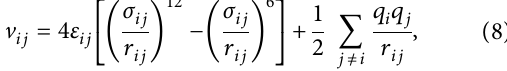
o C. The relationship ( ρ � 0.00758333853 %W NaCl and ρ t at 25 t NaCl +0.9942949) is obtained by using